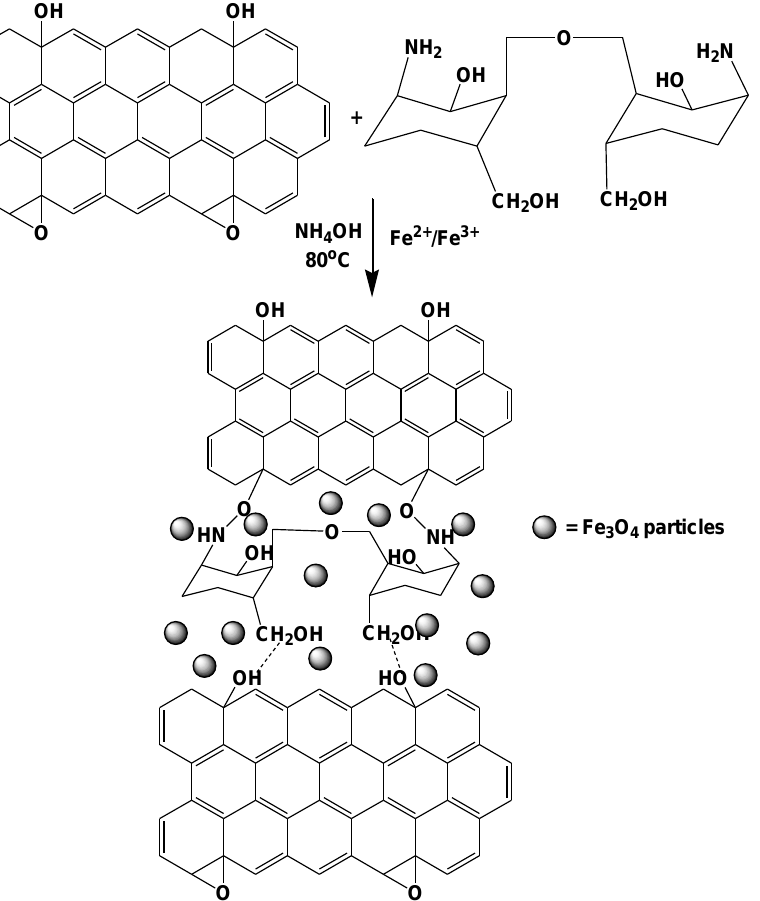
Figure 10. Schematic representation of formation of magnetic chitosan-graphene oxide nanocomposite. Reprinted with permission by Elsevier